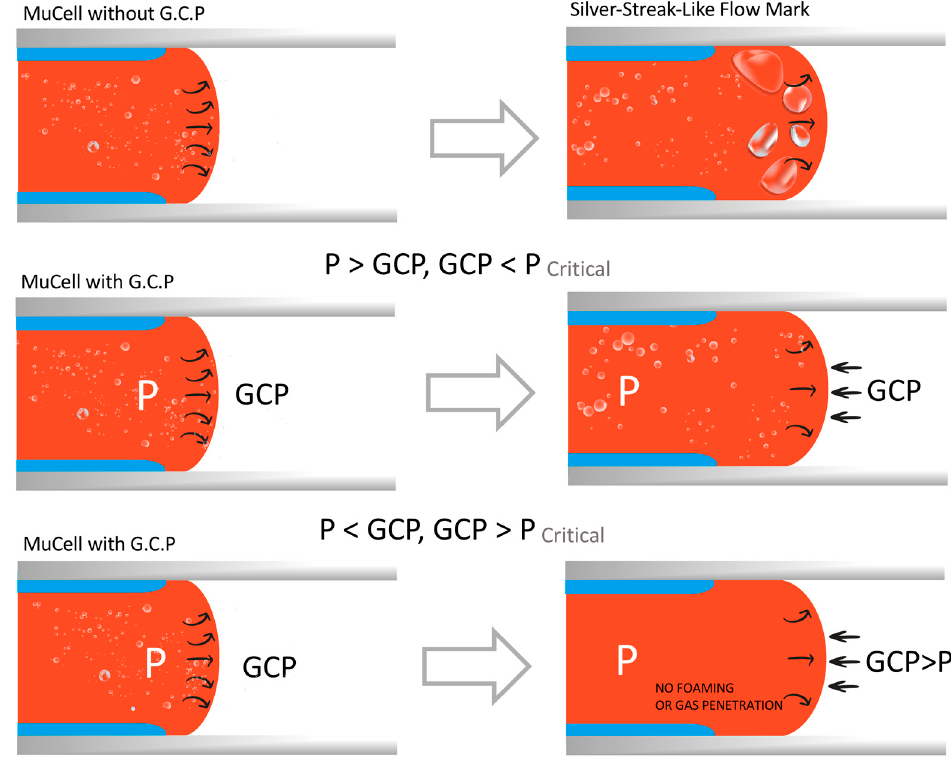
Figure 1. Effects of GCP control on the foam structures.